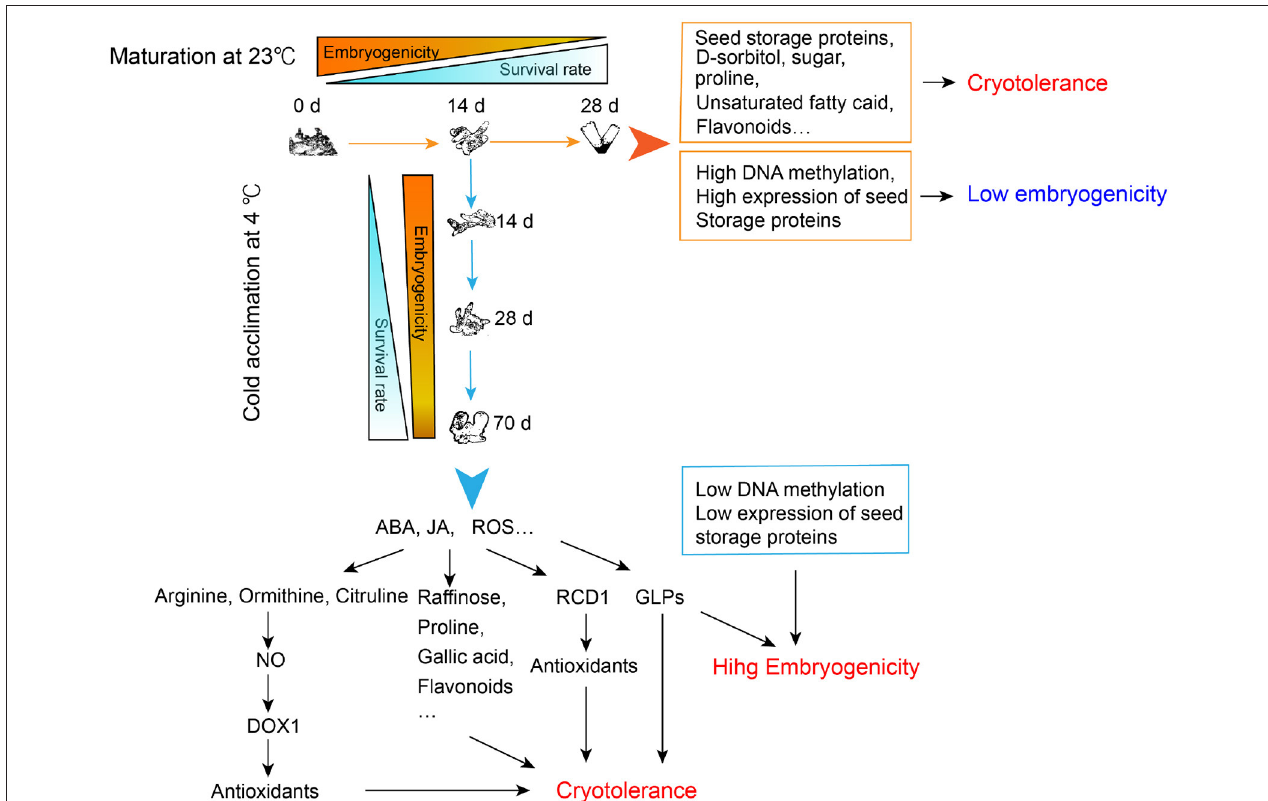
FIGURE 8 | Regulation of cryotolerance and embryogenicity of developing somatic embryos with normal maturation and cold acclimation treatments in Picea glauca . ABA, abscisic acid; JA, jasmonate; ROS, reactive oxygen species; NO, nitric oxide; DOX1 , α -dioxygenase1; RCD1, radical-induced cell death1; GLPs, germin-like